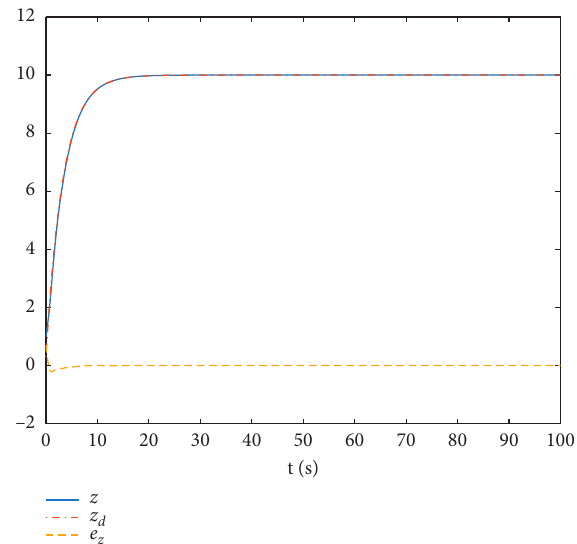
Figure 4: Trajectories of position z , ideal position z